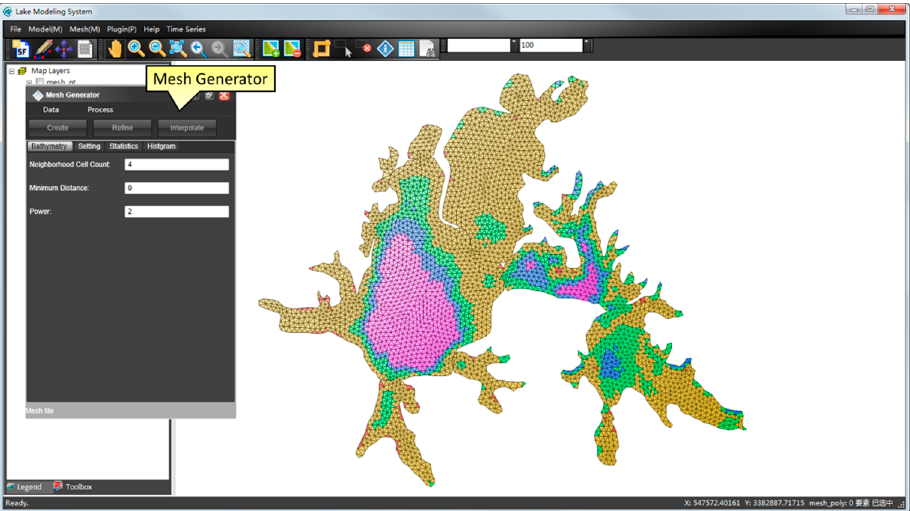
Figure 4. Grid generation tool.